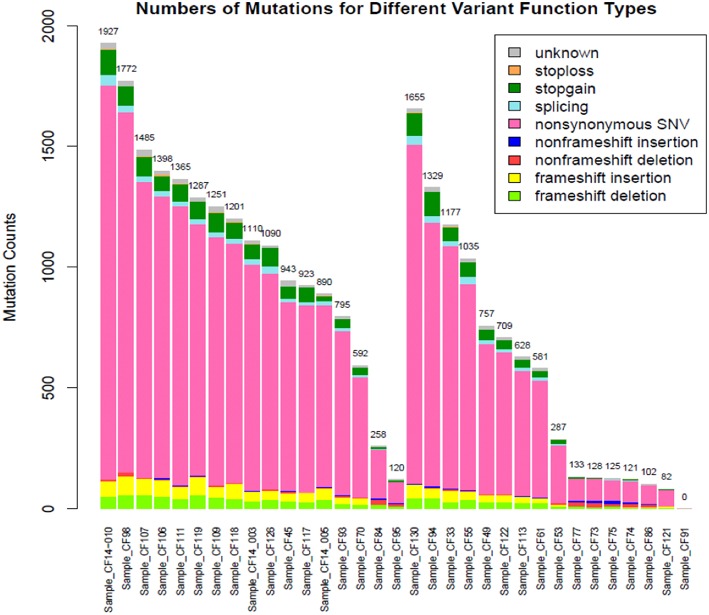
Number of mutations for different functional types for the cancer (left) and control (right) groups.